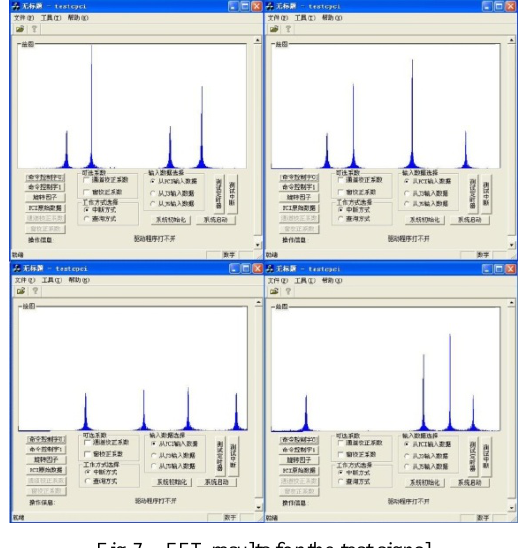
Fig.7 FFT results for the test signal